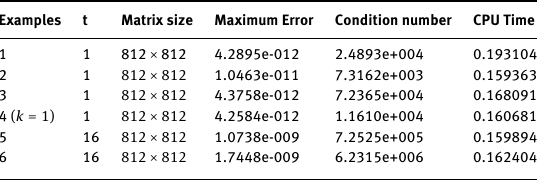
Table 14: Maximum errors E N and condition numbers of coefficient matrices on overlapping grids ( p = q = 3) when N x = 10 and N t = 10.